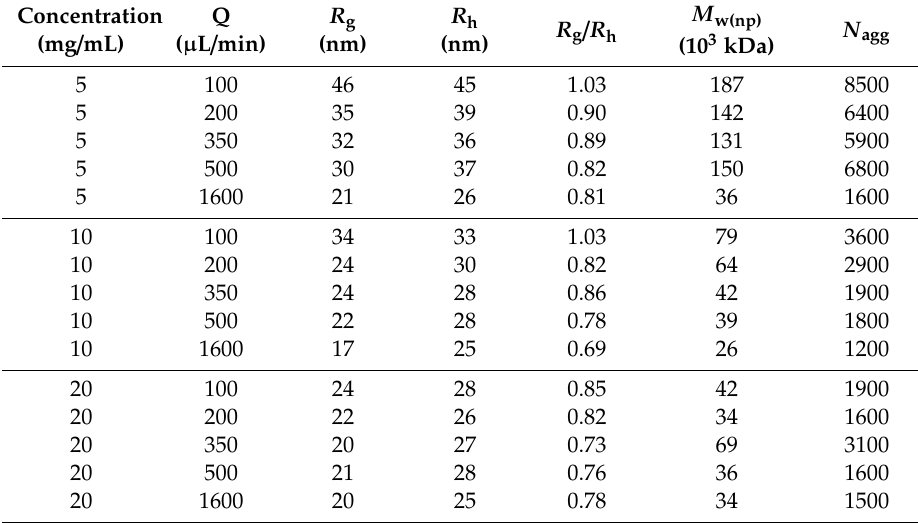
Table 2. Characteristics of block copolymer A (mPEG 5K - b -p(HPMA-Bz) 17.1K ) nanoparticles as determined by asymmetric flow field-flow fractionation connected to multi-angle laser light scattering detector